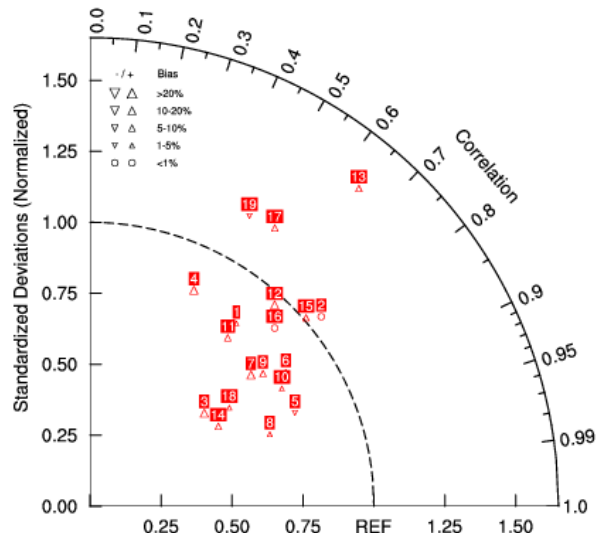
Figure 2. Taylor diagram of the annual mean SSTs from OISST v2 compared with 19 stations-based observations, REF stands for reference values of SST observations. The radial distance from the origin is proportional to the standard deviation ratio. The triangles and circle denote the bias between OISST and stations-based observations.